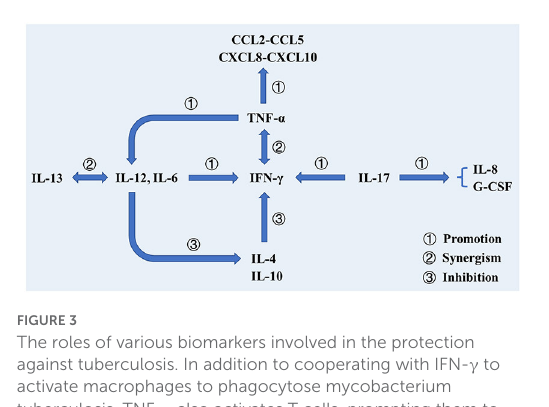
FIGURE3 The roles of various biomarkers involved in the protection against tuberculosis. In addition to cooperating with IFN- γ to activate macrophages to phagocytose mycobacterium tuberculosis, TNF- α also activates T cells, prompting them to produce cytokines. Additionally, TNF- α can promote DC differentiation and promote IL-12 production. Il-12 cooperates with IL-13 to promote the production and efficacy of IFN- γ and inhibit the production of IL-4. IL-17 participates in the production of IFN- γ and promotes the production of IL-8 and G-CSF, thereby stimulating neutrophils to the site of infection. responses caused by Mtb in vivo (36). These changes may affect the uptake and phagocytosis of Mtb by immune